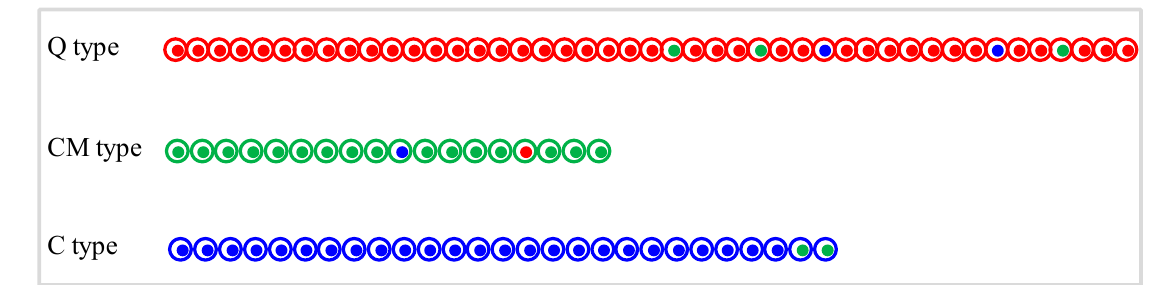
Figure 5. Type of each soil sample according to the most abundant mineral(s) ― carbonates (blue), clay minerals (green), and quartz (red); each pair of circles (empty and filled) represent a soil sample; the spectral-based classification (empty circle) fits the XRD analysis results (filled circle) where the circle color is identical.